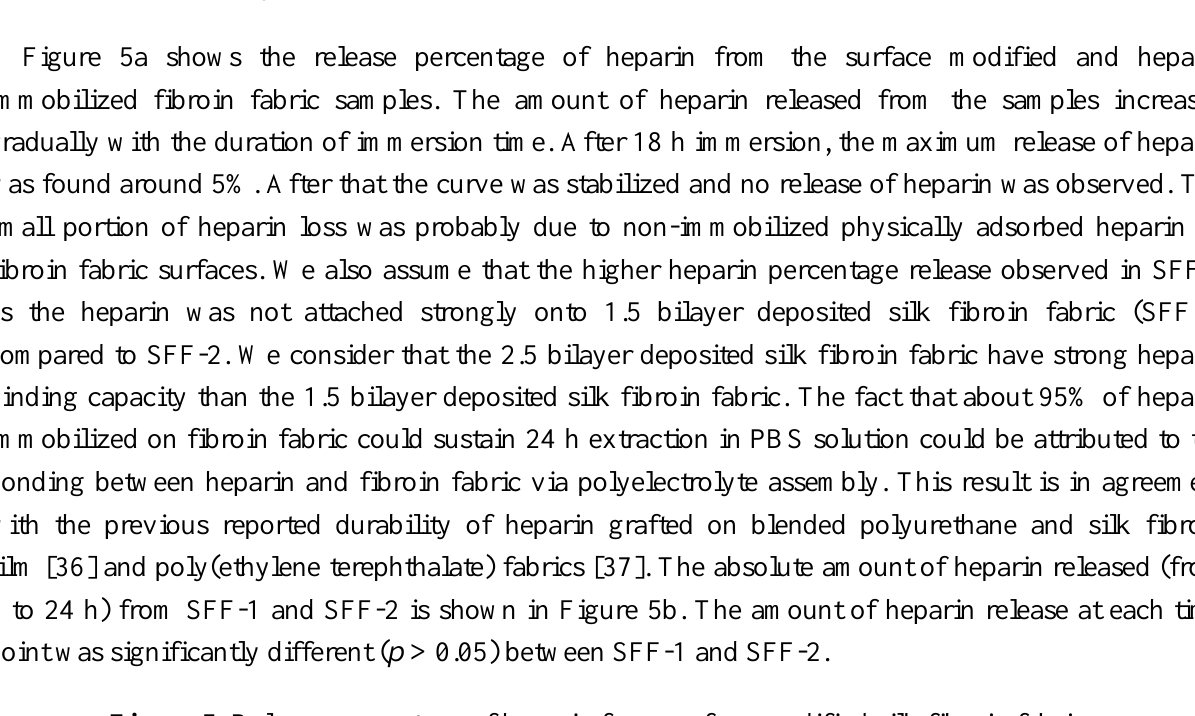
Figure 5. Release percentage of heparin from surface modified silk fibroin